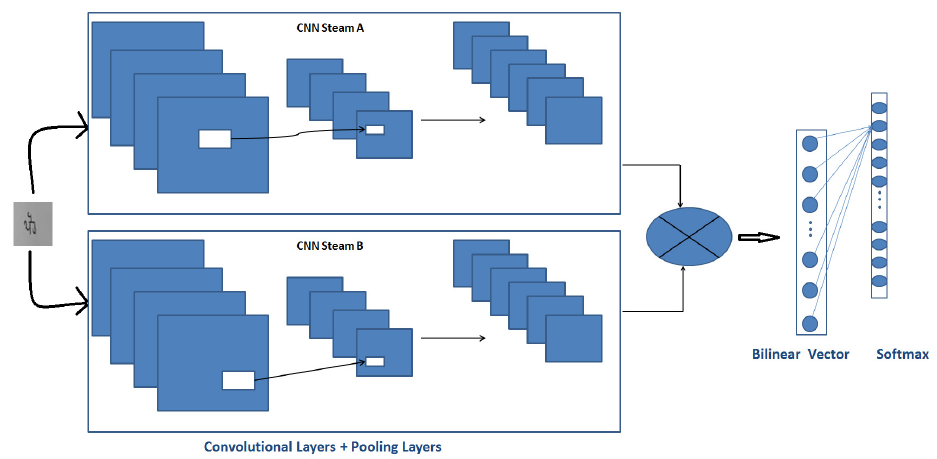
Figure 5. Architecture of bilinear CNN.